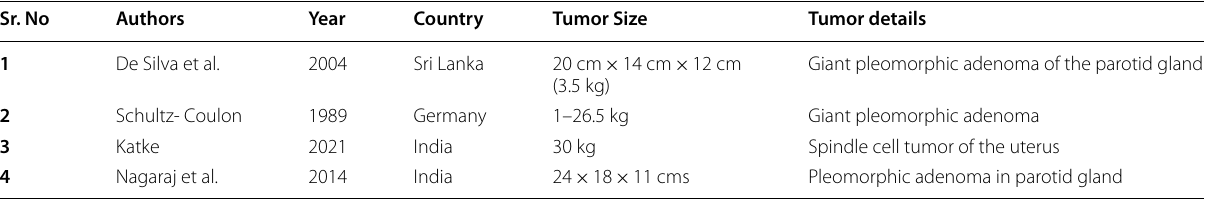
Table 1 Previously reported large-size tumors Sr.